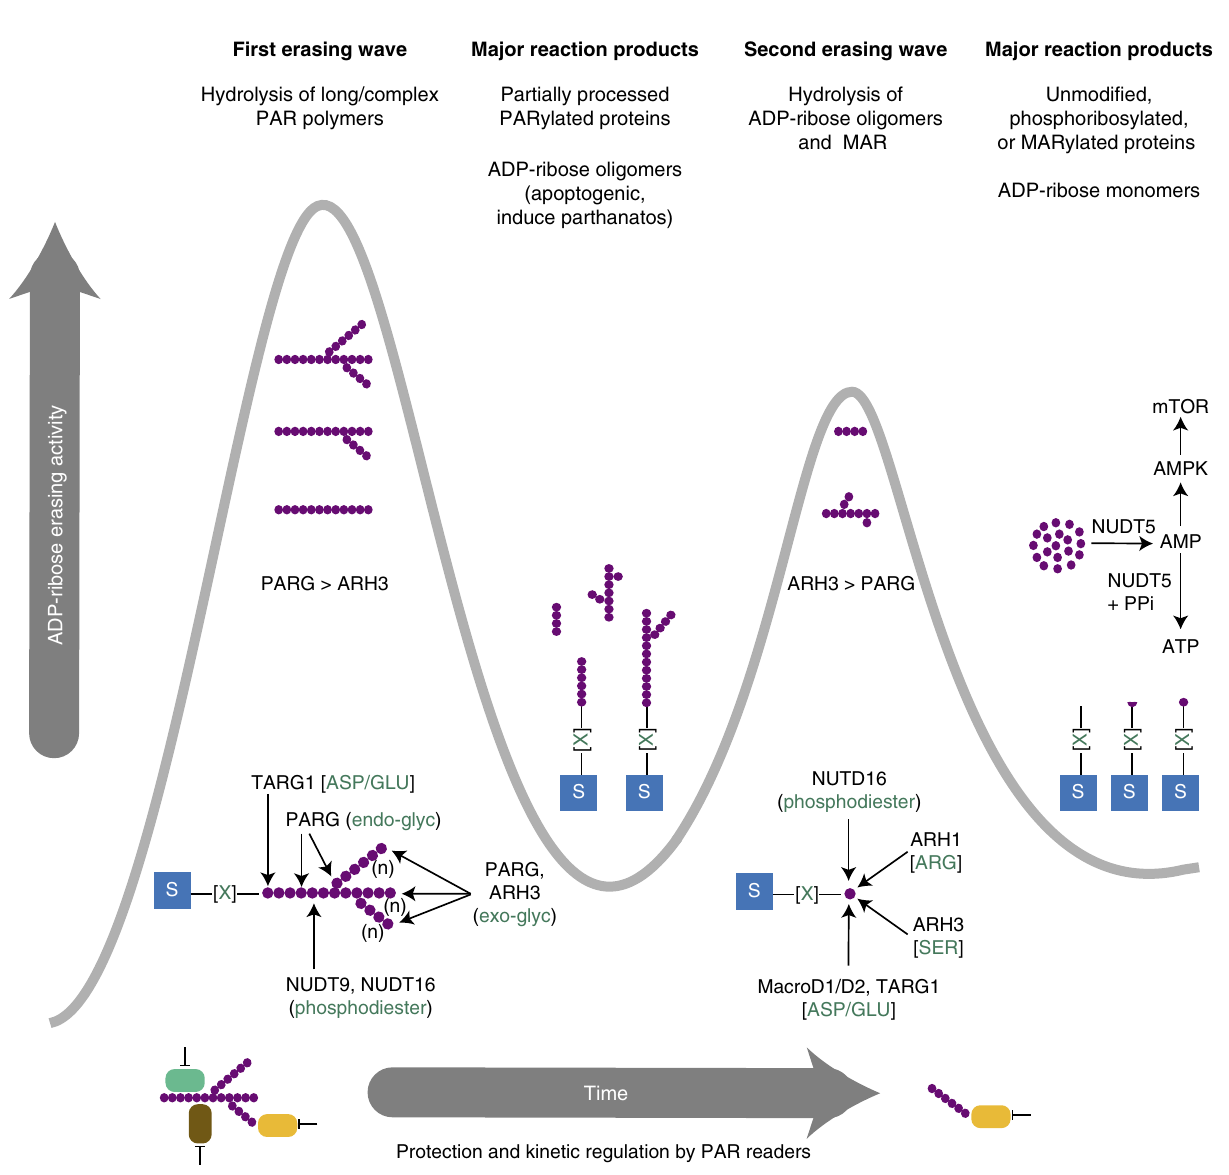
Fig. 4 The dynamic mechanism of ADP-ribosylation reversal. ARTDs consume NAD + and transfer ADP-ribose moieties onto target substrates (blue boxes) on different amino acids side chains (green [X]). These proteins can have a variety of different ADP-ribosylation modi fi cation patterns, as described in Fig. 1. In the context of severe genotoxic insult, complex PAR polymers composed of large and branched molecules are synthesized by ARTD1 and ARTD2 (PARP-1 and PARP-2). These polymers are rapidly recognized and processed by a variety of erasers in a biphasic mode. At the same time, a